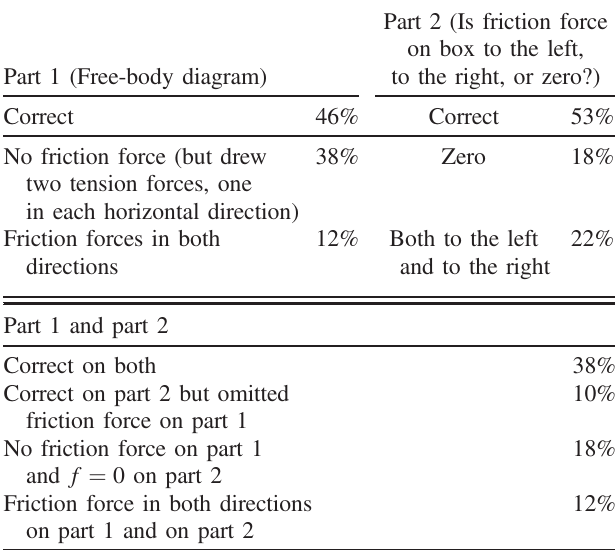
TABLE I. Student responses to the tug-of-war question ( N ¼ 68